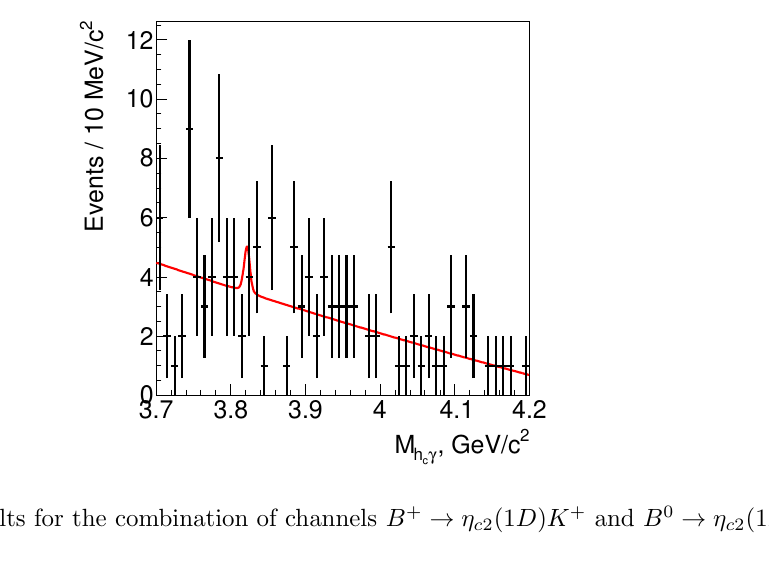
(cid:17) c 2 (1 D ) K + (left) and B 0 !